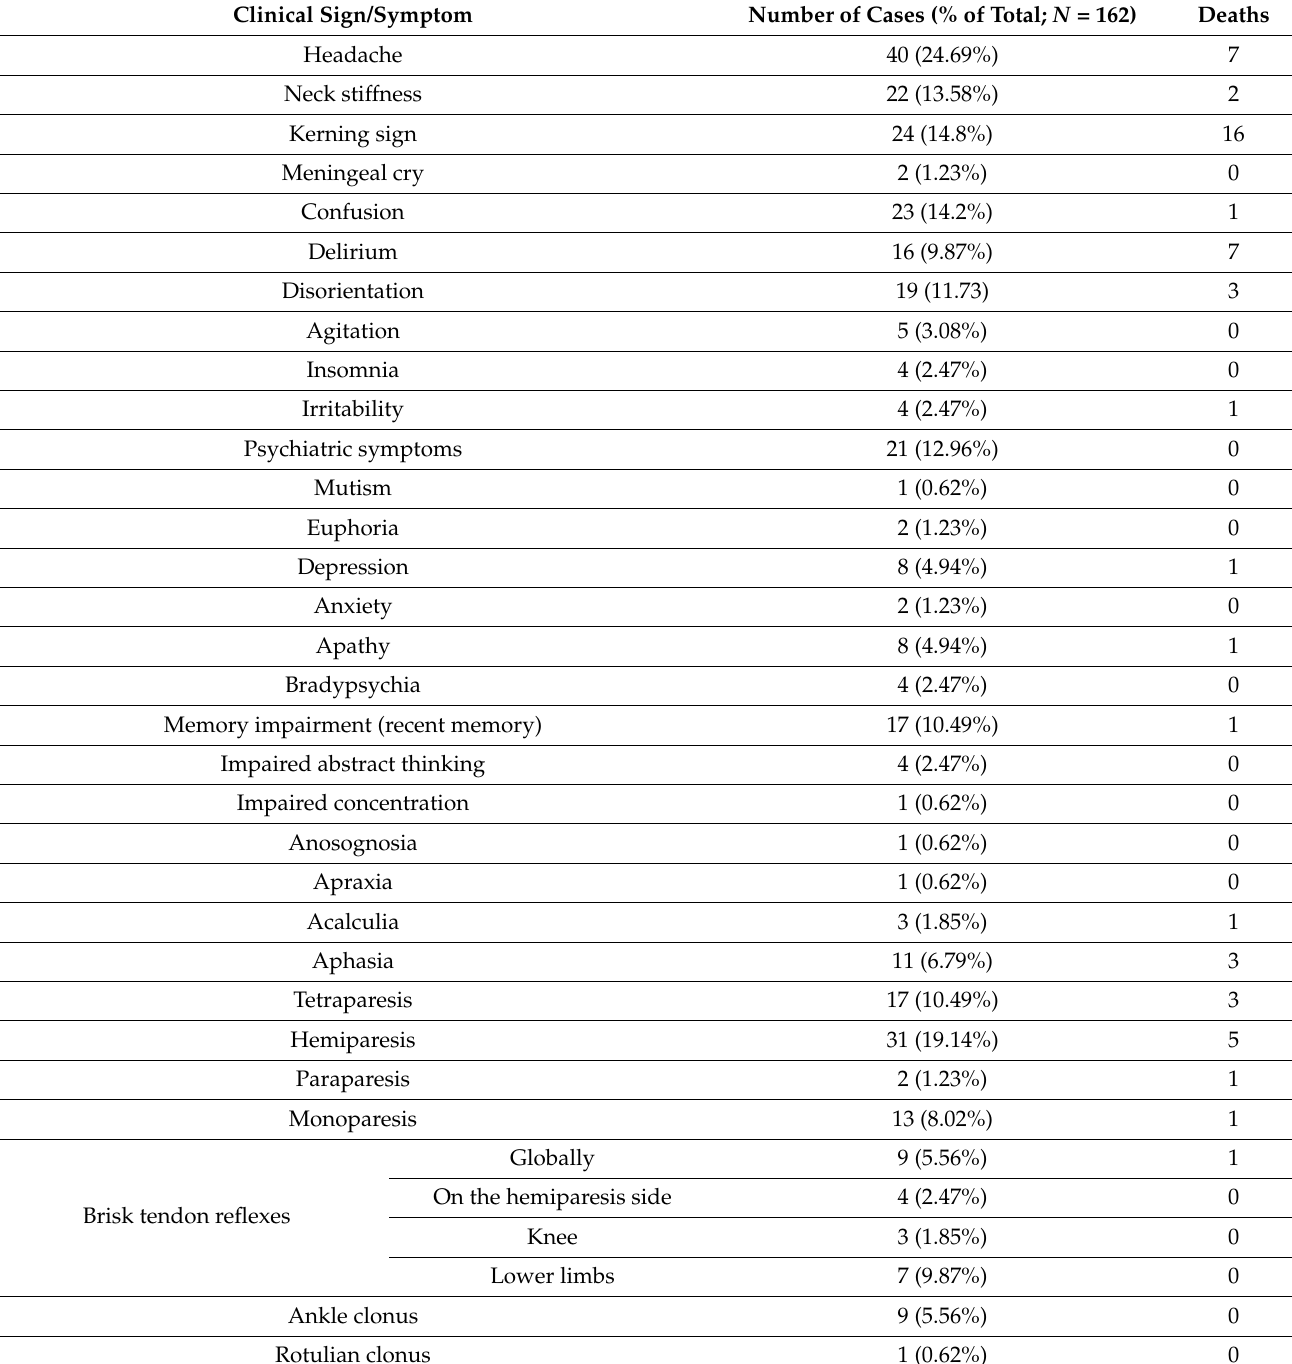
Table 1. Clinical symptoms and signs of included